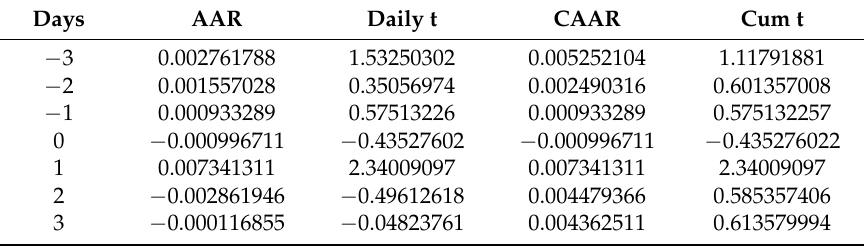
Table 4. Event study results of banks for the third event. Source: Authors’ work.